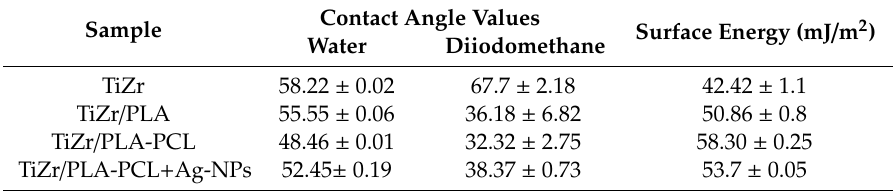
Table 4. Contact angle values and surface energy for samples after NaOH treatment.